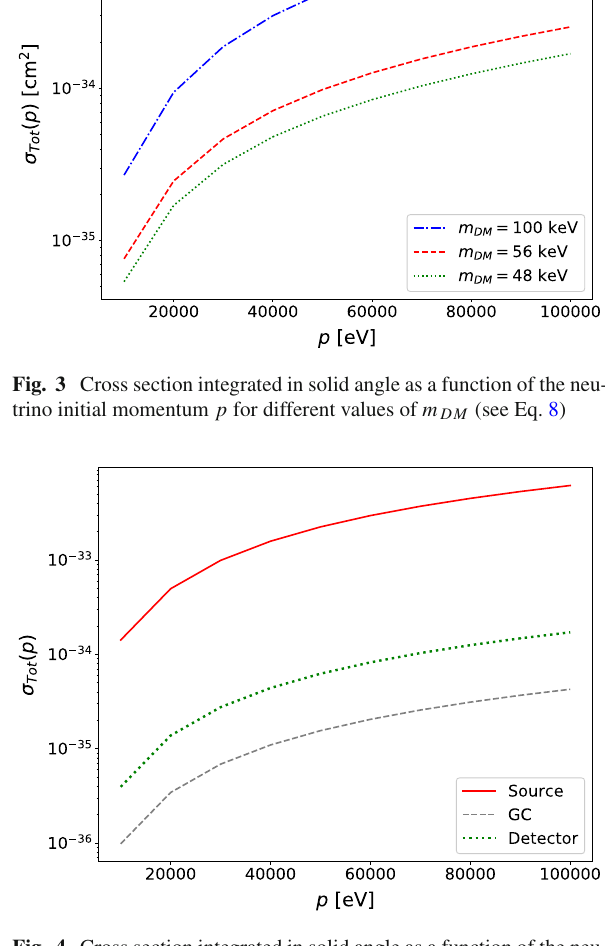
Fig. 4 Cross section integrated in solid angle as a function of the neu- trino initial momentum p for m DM = 100 keV, including the mixing between neutrino mass-eigenstates in the electron neutrino ν e . These results have been obtained by using ρ iso ( r ) , for different values of r . The corresponding positions are denoted by source ( r = 11 . 5 kpc), GC ( r = 0 . 1 kpc) and Detector ( r = 8 . 5